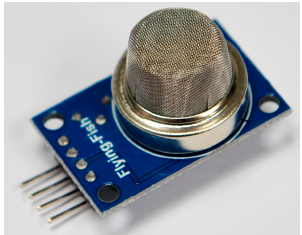
Figure 5. MQ-4 natural gas methane sensor.